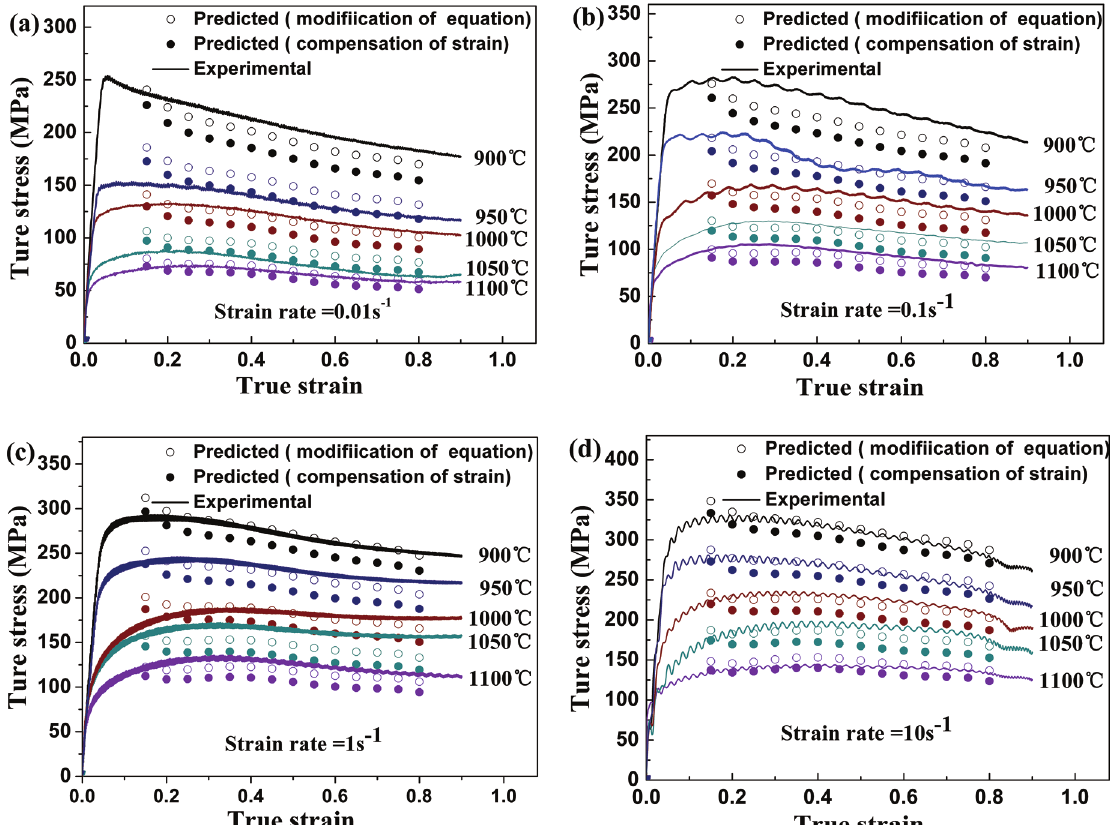
Fig. 7: Comparison between the experiment and predicted flow stress (including the compensation of strain and the modified equation) at strain rate of: (a) 0.01 s − 1 ; (b) 0.1 s − 1 ; (c) 1 s − 1 ; (d) 10 s − 1